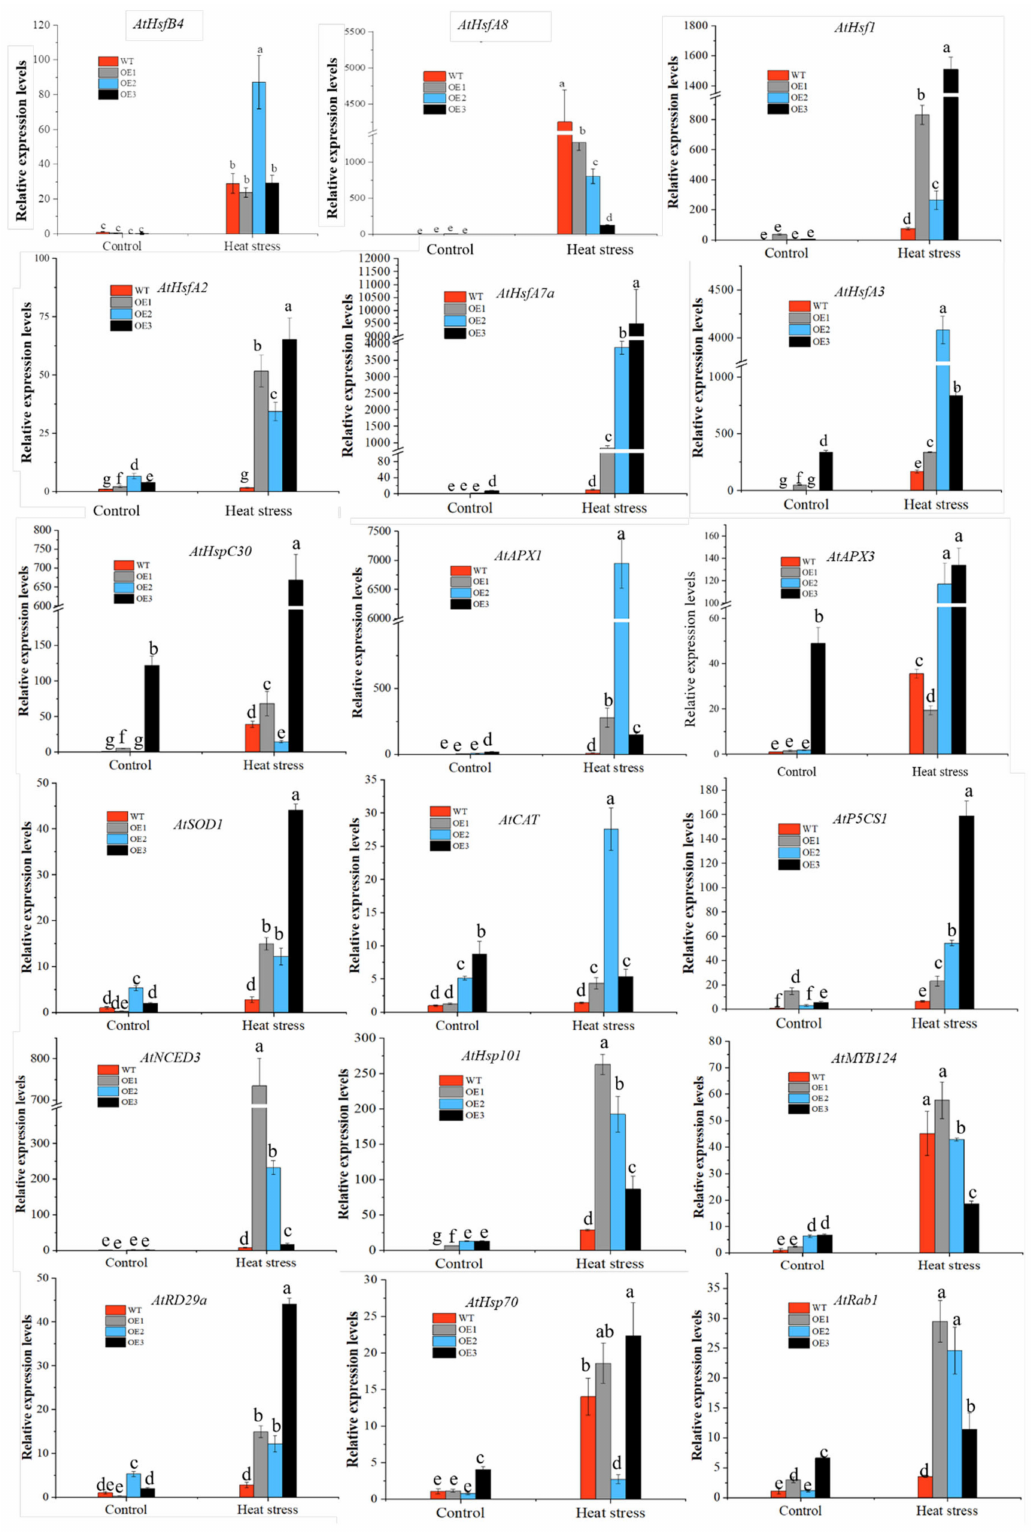
Figure 5. Expression patterns of stress–response genes in wild-type (WT), OE1, OE2, and OE3 lines before and after 42 ◦ C heat treatment for 24 h. Data are means with standard deviations of three biological replicates. Different letters denote statistical significance ( p ≤